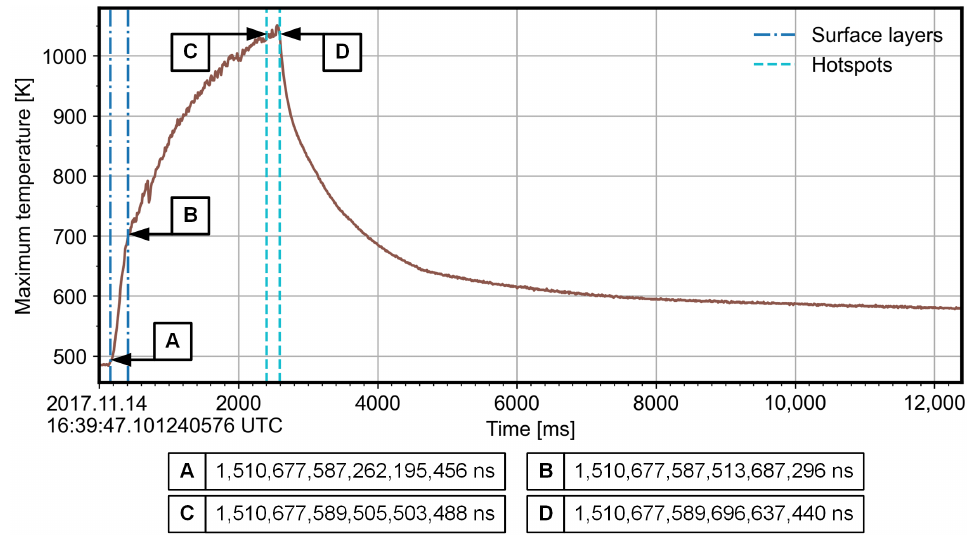
Figure 13. Maximum temperature evolution in Field of View (FoV) after applying a 3 × 3 median filter with the benchmarked sections marked.